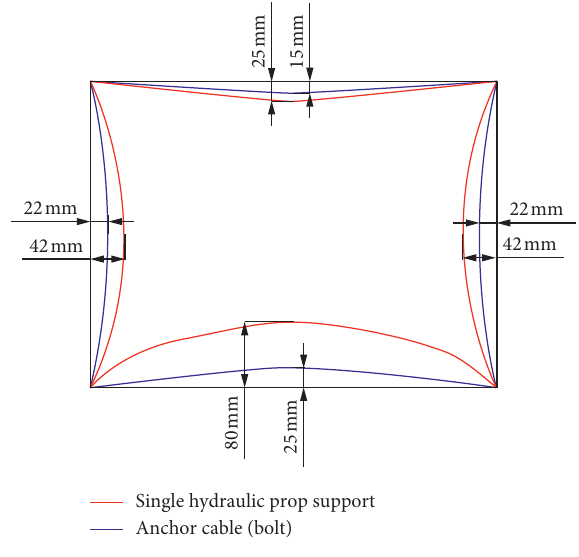
Figure 9: Displacement of model